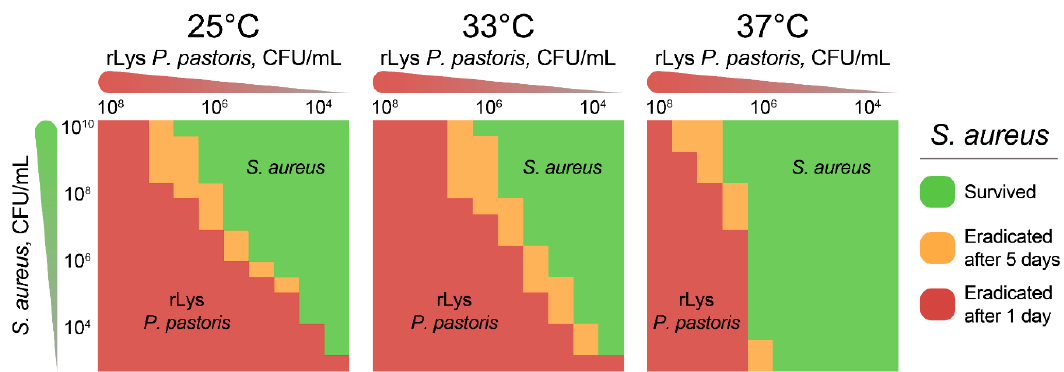
Figure 5. S. aureus eradication landscapes obtained by cocultivation with rLys P. pastoris . Various concentrations of S. aureus were cocultivated with rLys P. pastoris , resulting in S. aureus growth or eradication. Viable S. aureus cells were assayed after 1 day and 5 days. Areas indicating S. aureus / rLys P. pastoris ratios where live S. aureus was not detected after 1 day and 5 days are colored with red and orange, respectively. Areas with live S. aureus are colored with green. The detection limit of viable S. aureus cells is ∼ 10 3 CFU/mL.